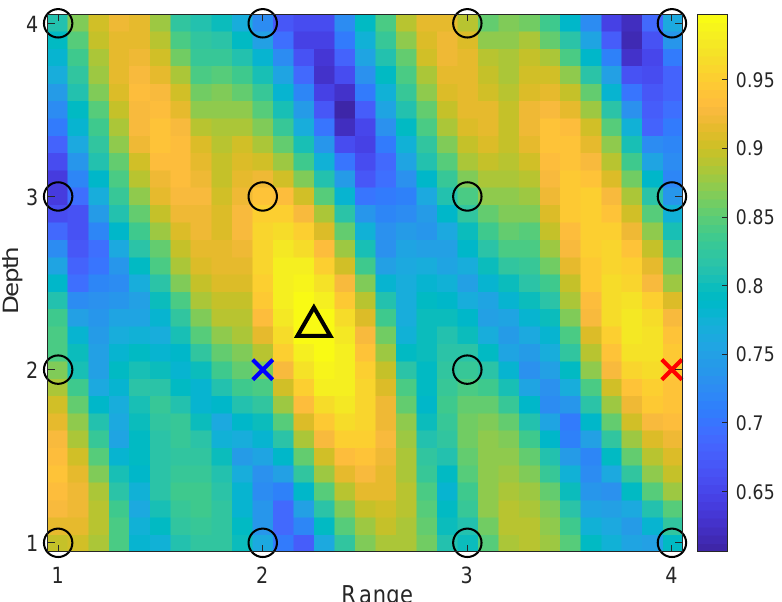
Figure 11. An example of the “continuous-range continuous-depth” non-coherent AF in an area of 3 m × 3 m. The circles are positions of coarse grid points; the triangle is the position of the receiver; the blue cross is the coarse grid point closest to the true position of the receiver; the red cross is the coarse grid point with the AF maximum on the coarse grid map; N T = 1.